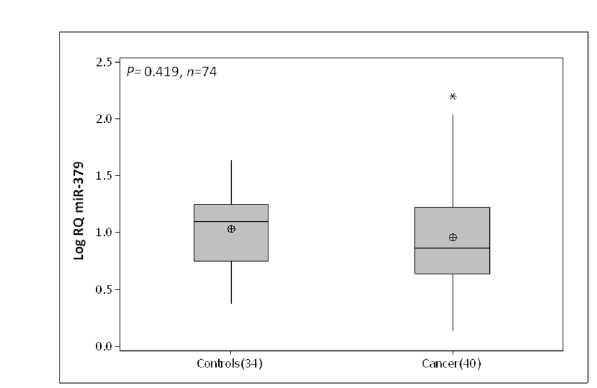
RQ, p<0.05) 10 Figure 5. Circulating miR-379 expression across breast cancer patients and controls. No significant difference was observed between circulating miR-379 in breast cancer patients (Mean(SEM) 0.95 (0.07) Log RQ) and healthy 10 controls (1.03 (0.05) Log RQ, p=0.42). 10 doi: